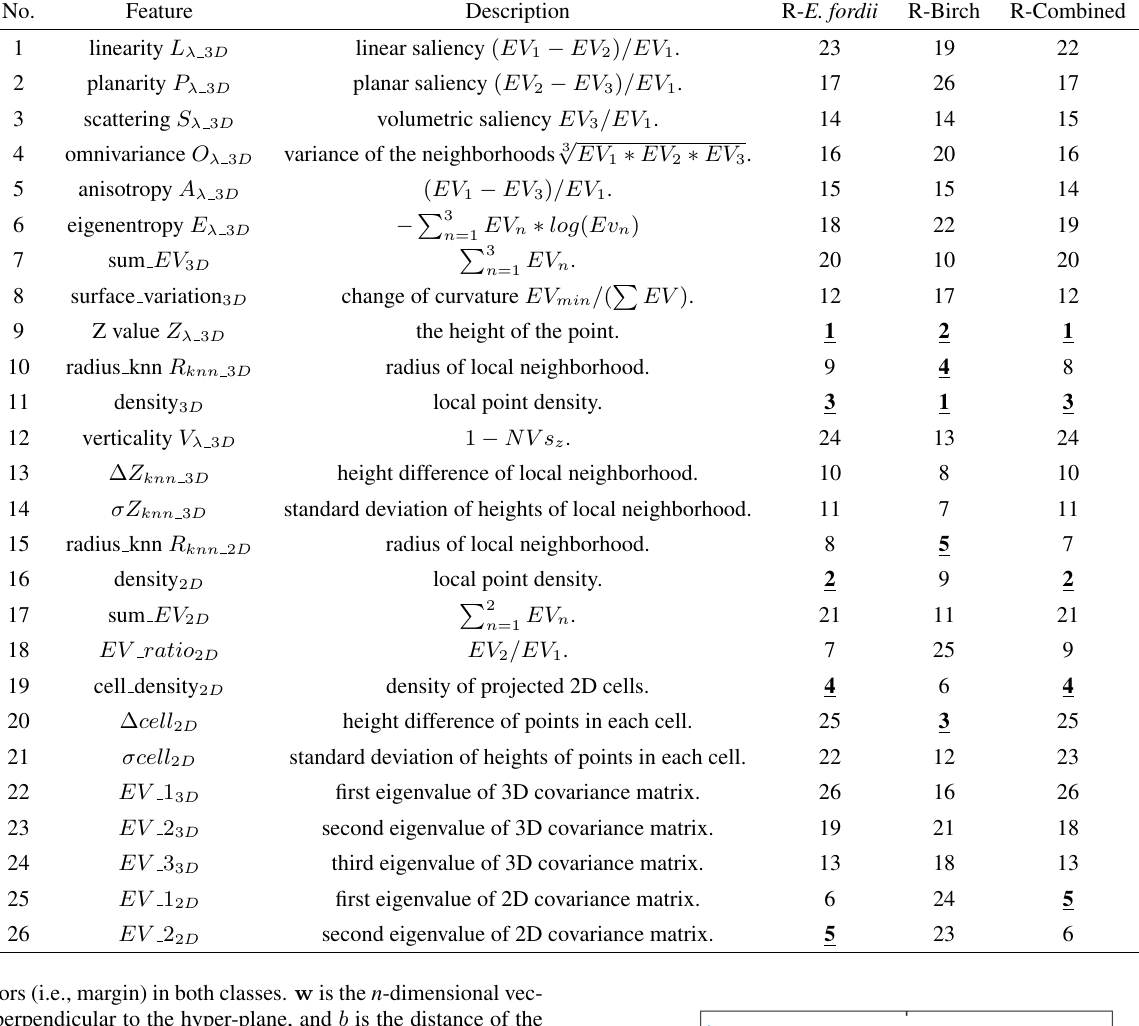
Table 1. Features extracted from the point cloud. EV denotes the eigenvalue and NV is the normal vector. EV s are sorted in a descend manner. ”R-” is the abbreviation of ”Ranking” form feature selection. ”R-Combined” means that the feature set is a combination of data from both trees. Top 5 ranked features are underlined.